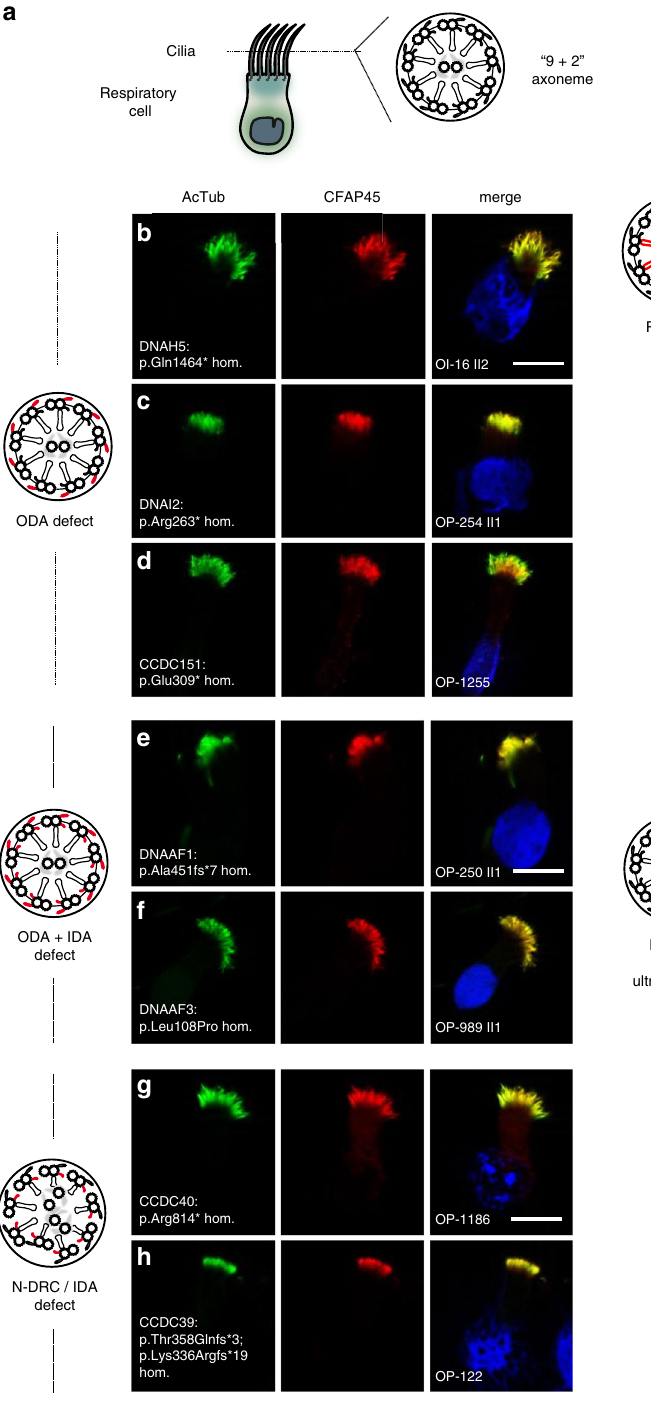
N-DRC / IDA defect